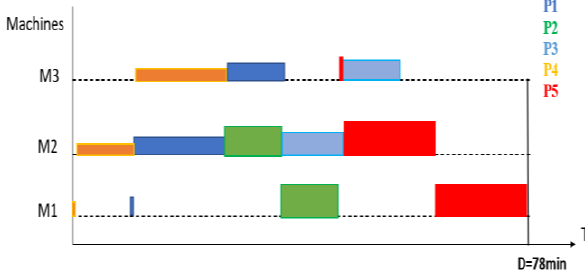
Fig 2: Scheduling of 5 Products- 3